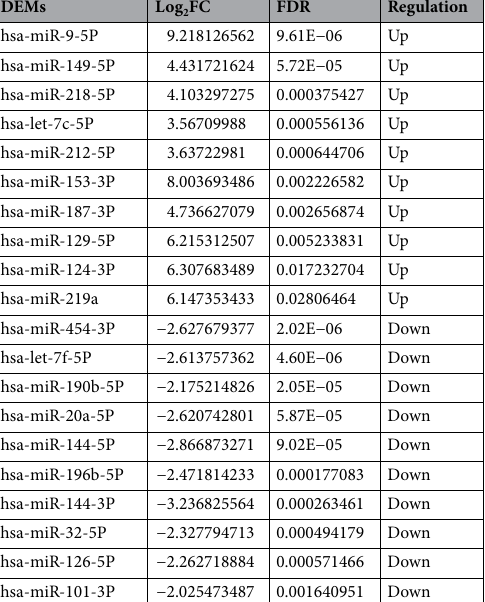
Table 2. The top 20 DEMs between patients with sepsis and healthy controls. DEMs differentially expressed miRNAs, FC fold change, FDR false discovery rate, miRNAs